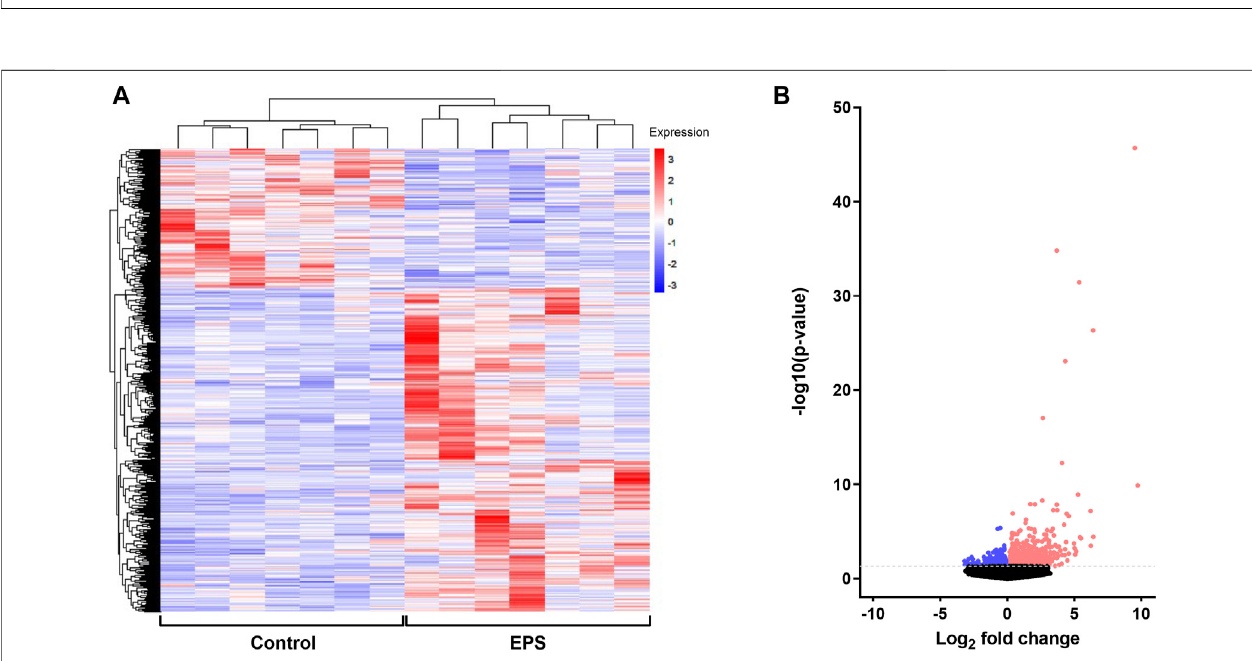
FIGURE 3 | Identi fi cation of differentially expressed genes (DEGs) in electrical pulse-stimulated myotubes from young male subjects. (A) Heat map showing DEGs after electrical pulse stimulation (EPS protocol 1). Each row represents a gene, whereas each column represents control or EPS-treated myotubes from seven donors. (B) Volcano plot ofidenti fi ed transcripts indicating 952 DEGs (665 upregulated and 287 downregulated). The color red on the fi gures represents upregulated DEGs and blue downregulated DEGs.